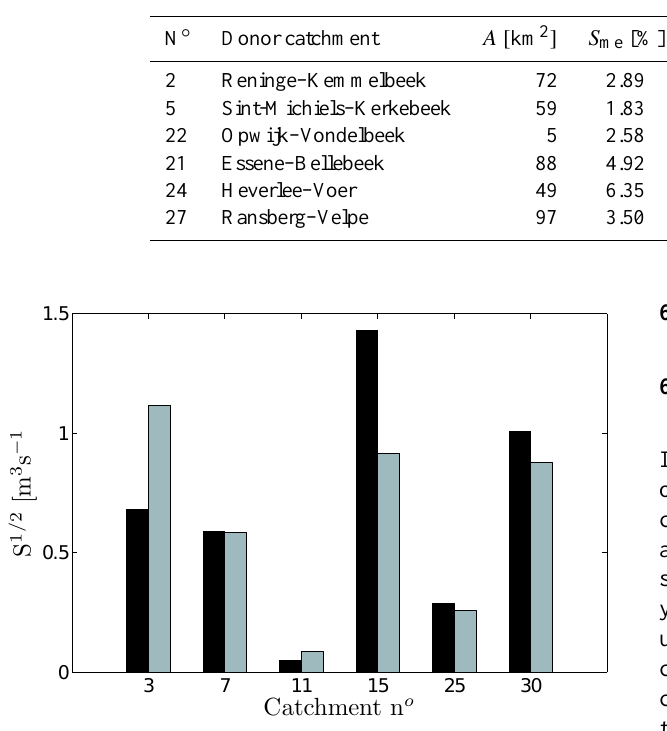
Table 3. Overview of the selected donor catchments and corresponding properties. A is the drainage area of the catchment. S me is the local slope (mean slope of a grid cell) averaged over all grid cells within the catchment. sc% max and lc% max are respectively the soil class and land cover class with the highest relative area within the catchment.